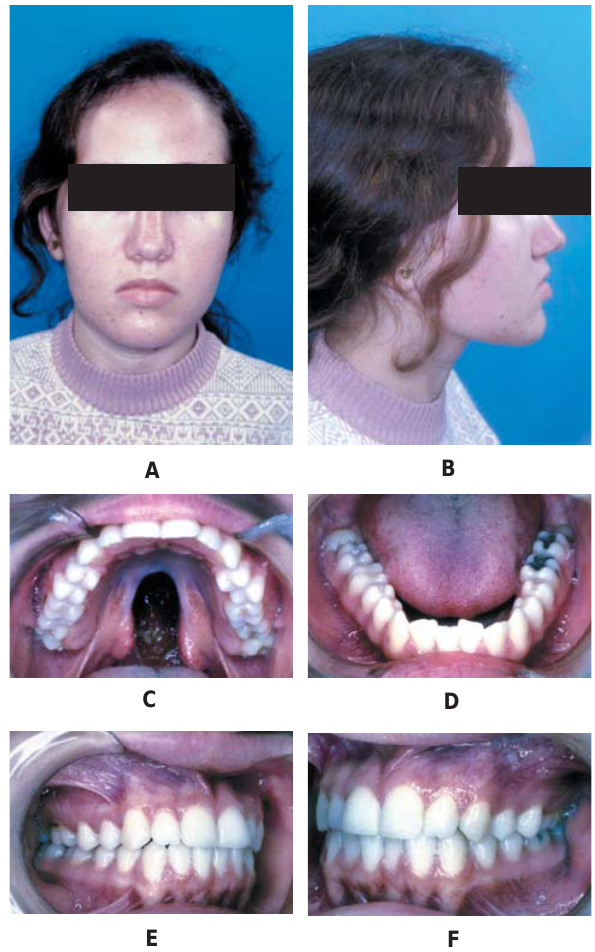
FIGURE 5- Patient with isolated cleft palate. Frontal and lateral facial analyses and occlusal analysis of adult patient